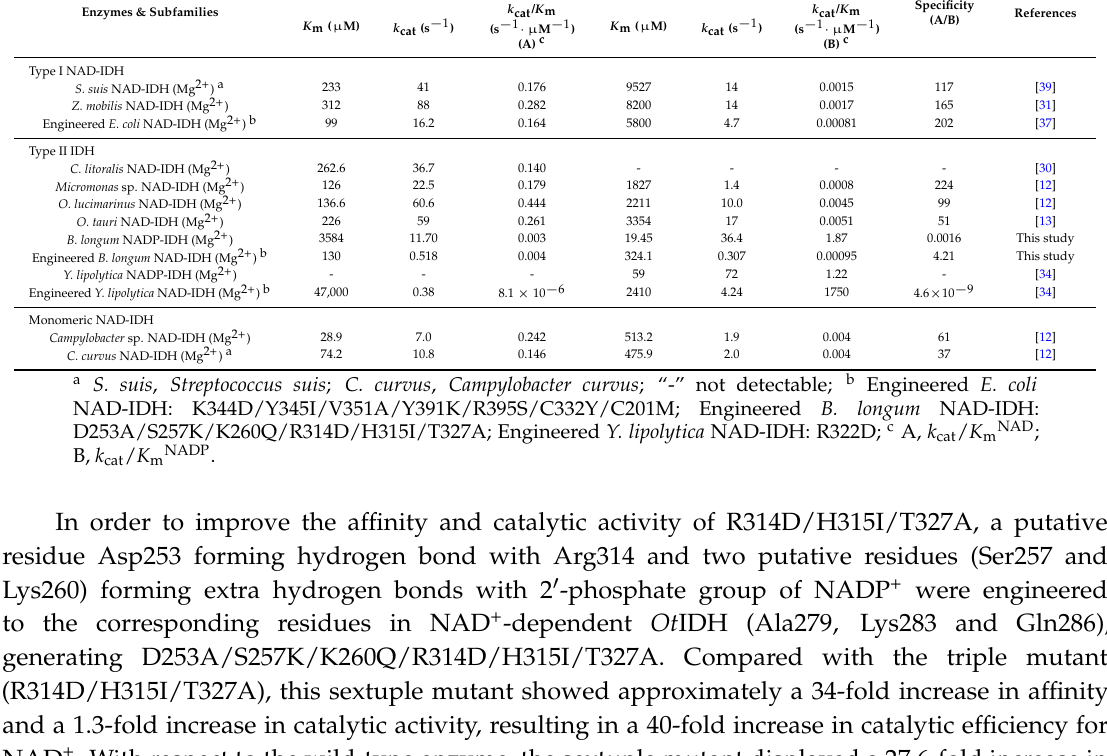
Table 3. Comparison of kinetic parameters between sextuple mutant and other IDHs.